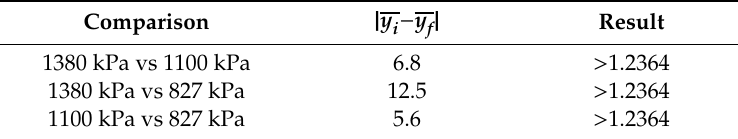
Table 6. Results of the LSD means comparison.